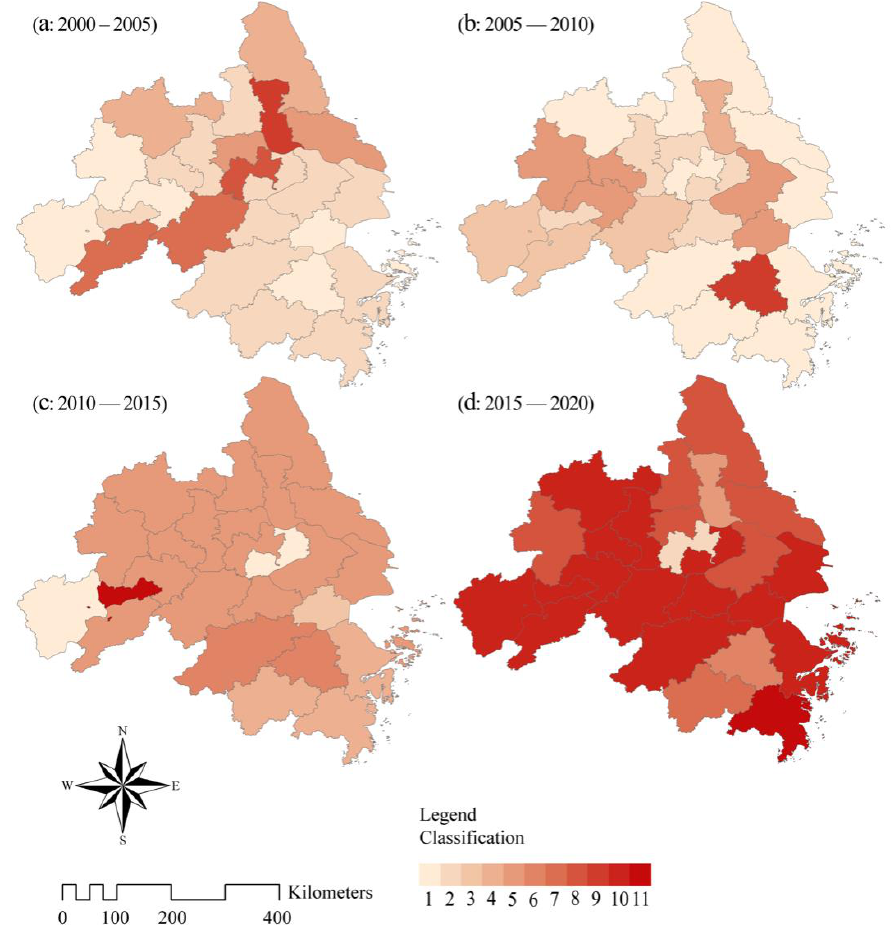
Figure 14. The characteristics of carbon emission composite impact factors in different periods.